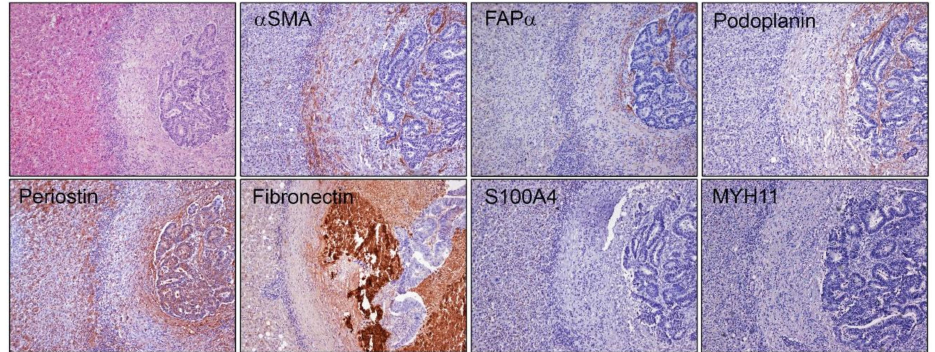
Figure 4. Immunohistochemical staining of a desmoplastic liver metastasis from CRC. We used classical markers for carcinoma-associated fibroblasts ( α SMA, FAP α and S100A4). As shown in the microphotographs, the outer half of the capsule stains for α SMA-positive fibroblastic cells, while the inner half does it for FAP α , as also shown in Figure 3. We did not observe staining for S100A4 (also known as FSP1, Fibroblast Specific Protein 1) on cells of the capsule. Podoplanin, which is a type 1 integral membrane glycoprotein and is characteristic of particular CAF subsets, also stains in cells of the inner half of the membrane, as is the case for various proteins of the extracellular matrix, such as fibronectin and periostin (among others, not